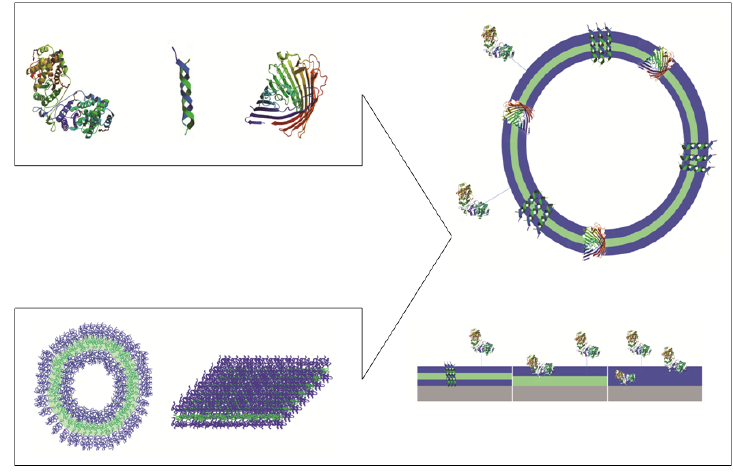
Figure 1. A schematic image of biomolecules that combine with a membrane-forming polymer to biomolecule-polymer hybrid-materials. Enzymes, membrane proteins and biopores can either be inserted into, or attached to, the membrane. The polymer membrane can be a hydrophilic monolayer (blue) or a bi- or tri-layer with additional hydrophobic (green) and hydrophilic parts, respectively. The shape of such a membrane can either be planar or spherical.